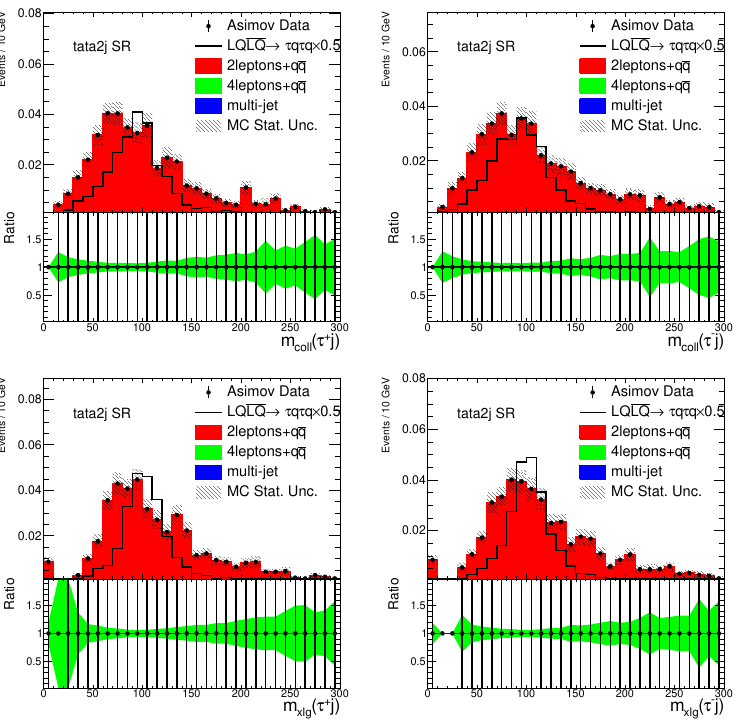
Figure 8 . The distribution of the reconstructed mass of a lepton candidate and a jet candidate in the signal region “tata2j” based on the collinear approximation method (top) and the method in ref. [83] (Bottom). The left one is m ( τ + j ) and the right one is m ( τ − j ) . The black points in the upper pads show the asimov data which is just the sum of all background events with uncertainties completely suppressed for better illustration. The ratio of the asimov data and the total background is shown in the lower pads, where the error bars on the black points represent the expected data uncertainty while the green bands represent the total MC statistical uncertainty.